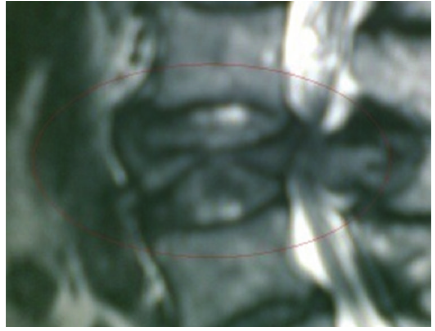
Figure 2: T2 high sign with dural sac compression.